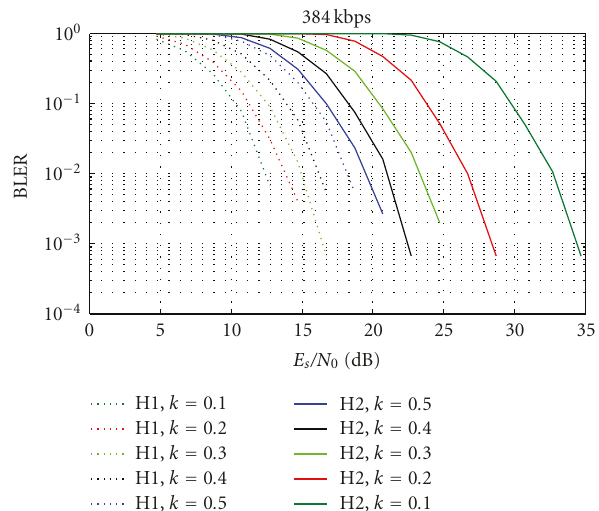
Figure 8: BLER versus E s /N 0 for hierarchical 16-QAM varying k , Rb = 384kbps, VehA 30km/h.